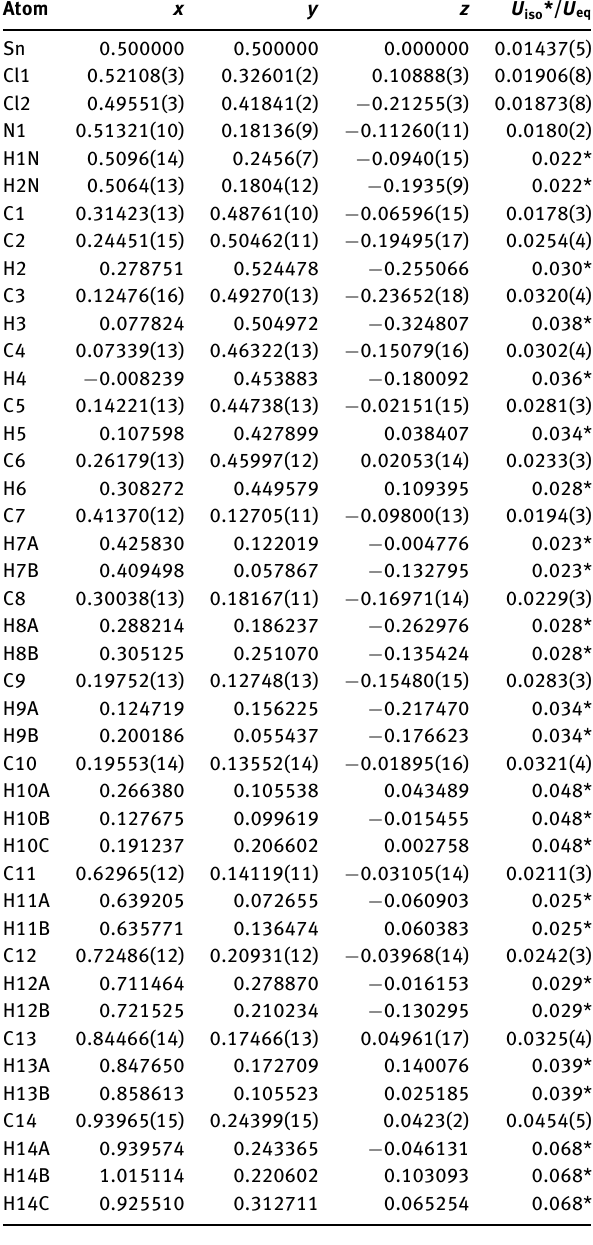
Table 2: Fractional atomic coordinates and isotropic or equivalent isotropic displacement parameters (Å 2